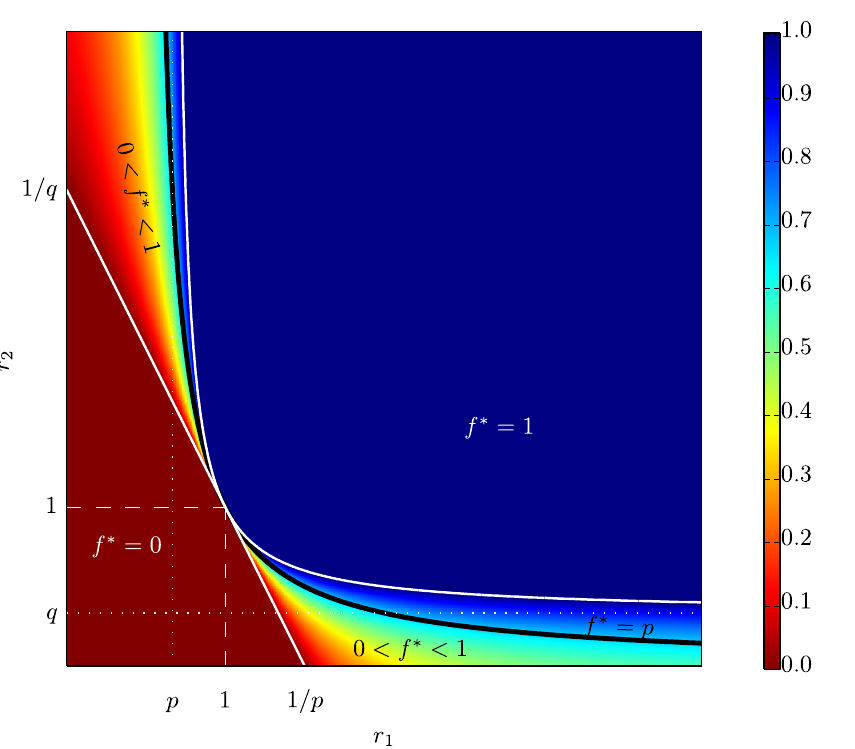
Fig 1. Regions of the ( r 1 , r 2 )-plane that imply deterministic ( f � = 0 or 1) or randomizing (0 < f � < 1) behavior, where r j = c aj / c bj measures the relative fecundities of action a to action b in the two states j = 1, 2. The asymptotes of the curved boundary line occur at r 1 = p and r 2 = q . Values of r 1 and r 2 for which exact probability matching is optimal are given by the solid black curve. Source: Brennan and Lo [50, Fig